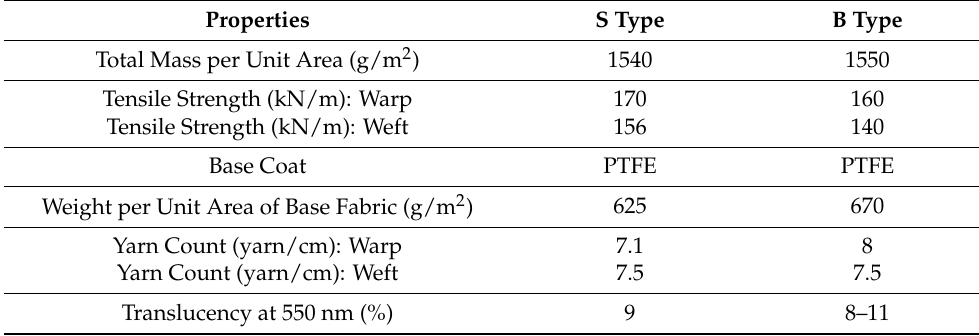
Table 1. Properties of investigated PTFE coated woven